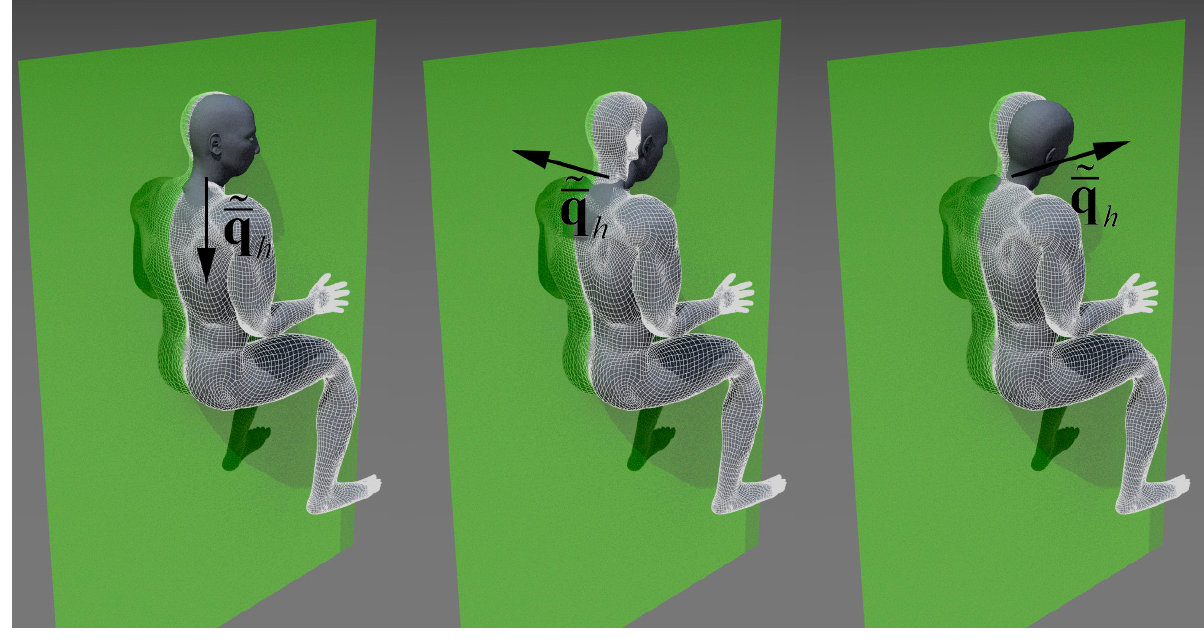
~ q  for the head-neck is represented. Yaw ( left ), pitch ¯ h q h for the head-neck is represented. Yaw (